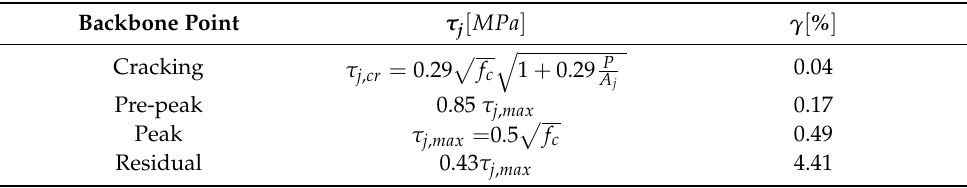
Table 7. Beam-column joint backbone critical points.